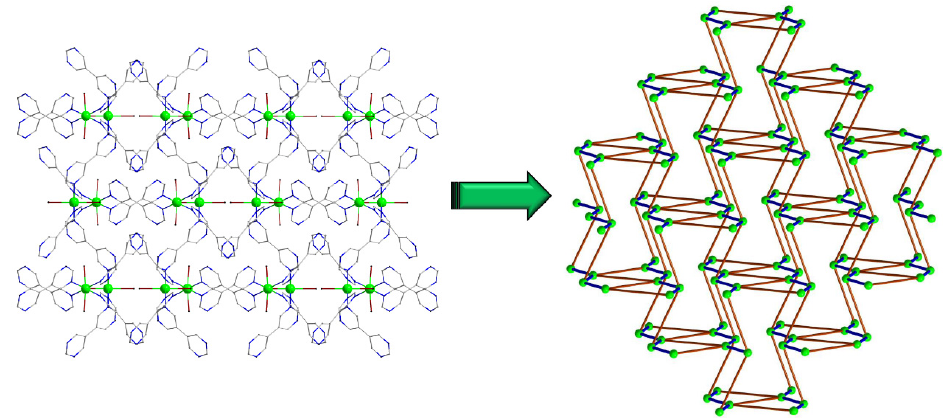
Figure 3. Schematic representations of ( a ) the pyramidal 4-connected node of Ni1 center, and ( b ) the planar 4-connected node of Ni2 center.